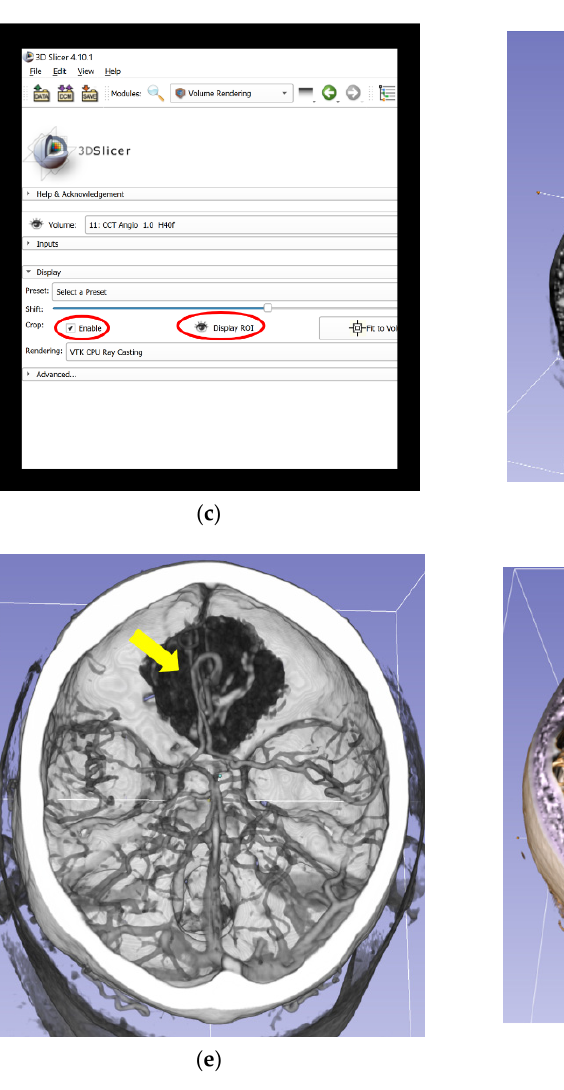
Figure 1. Reconstruction process of 3D-VR images from 2D-CT modalities (including CTA) and completion of the final VR scene in the 3D Slicer. ( a ) Import of original CT and CTA data in an anonymized DICOM format into 3D Slicer software to create a patient-specific database and selection of “CCT Angio-Default” (blue arrow) in the volume rendering window (red circled). ( b ) Performance of 3D-VR reconstruction of a skull (yellow arrow) in the volume rendering window. ( c ) Activation of the ROI function (red circled), which enables visualization of the meningioma and relevant vascular anatomy from different perspectives by partial omission of skull bones. ( d ) Lateral aspect of the meningioma (yellow arrow) and relevant vascular anatomy, simplified by using the ROI function. ( e ) Superior aspect of the meningioma (yellow arrow). ( f ) Superior lateral aspect of the meningioma (blue arrow) with different color displays. 2D, two-dimensional; 3D, three-dimensional; CT, computed tomography; CCT, cranial computed tomography; CTA, computed tomography angiography; DICOM, digital imaging and communications in medicine; ROI, regions of interest; VR, virtual reality.